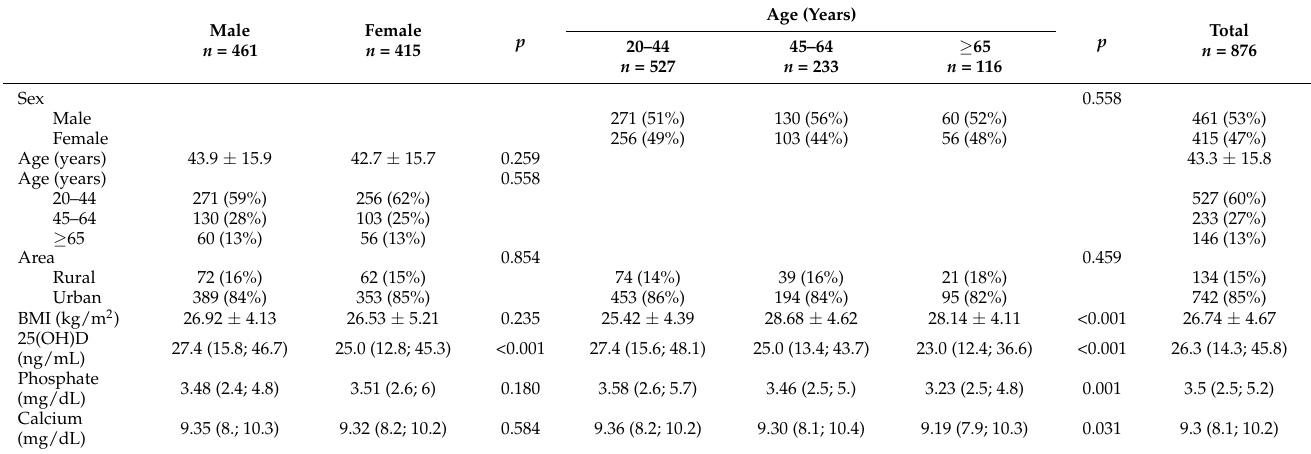
Table 2. Distribution of the sample of healthy patients by gender and